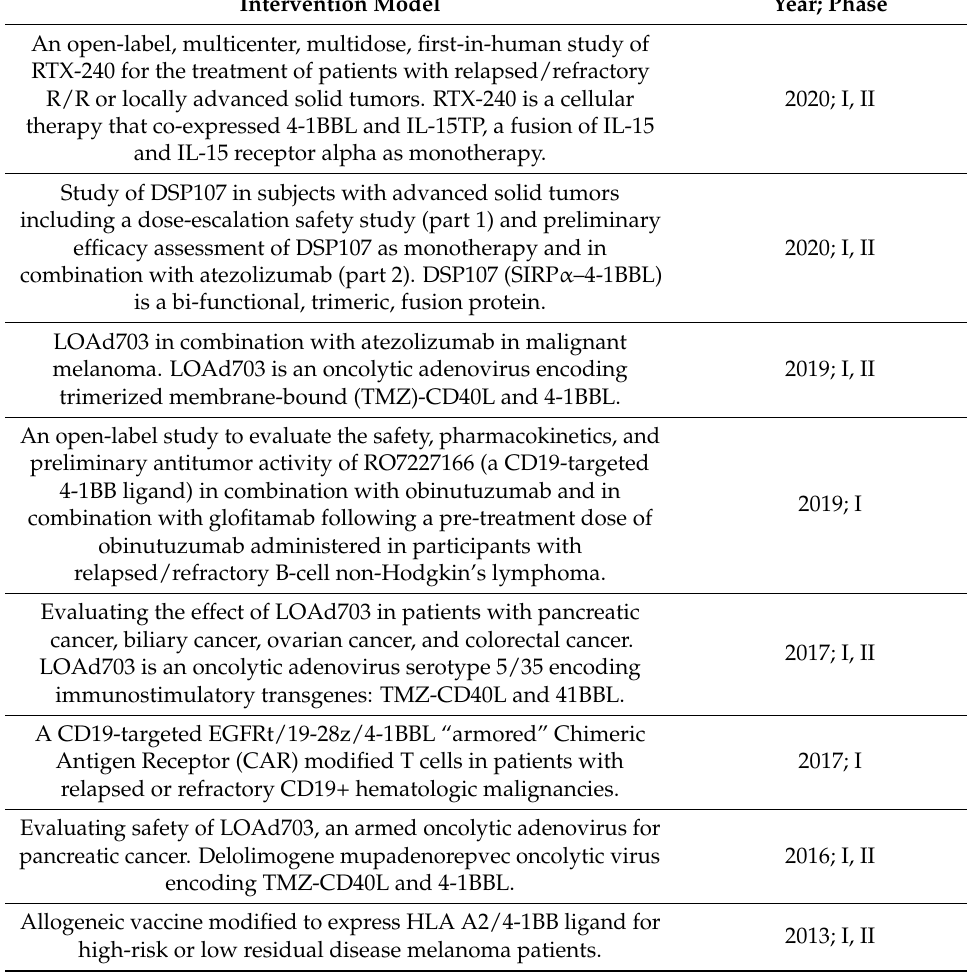
Table 2. Current Clinical trials with -4-1BBL. Intervention